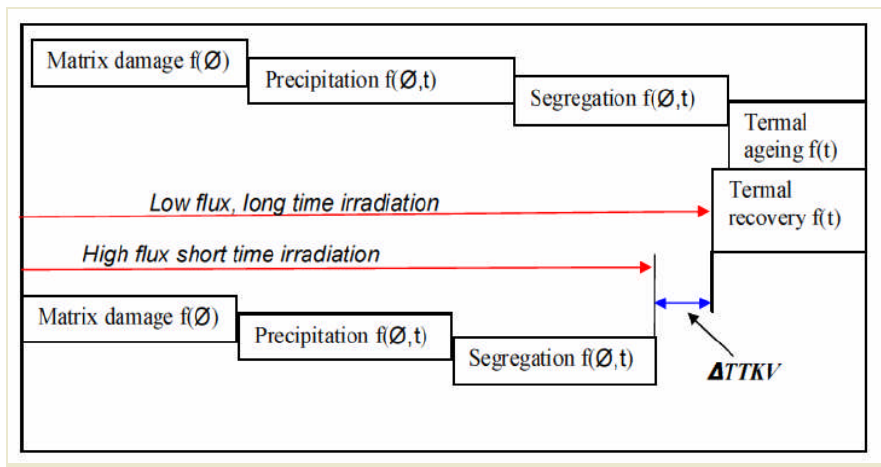
Figure 2. Summary of the RPV ageing mechanisms and comparison of high- and low-flux irradiation at low temperature ( ≤ 350 °C). At high-flux irradiation (in accelerated research facilities) the time is short for finishing the diffusion processes, and the role of thermal ageing and thermal recovery (annealing) is negligible. At higher temperature, the diffusion accelerated, and thermal annealing may reduce the radiation embrittlement [7].